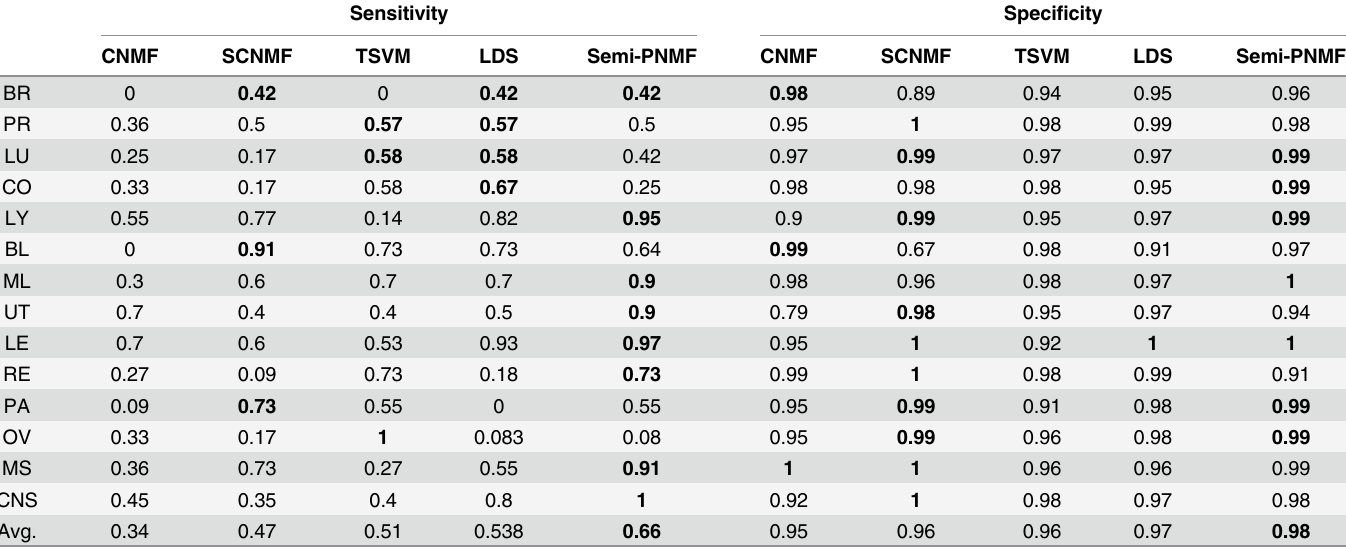
Table 2. Sensitivity and Specificity of the compared methods over 14 cancer subtypes on the GCM dataset. Sensitivity Speci fi